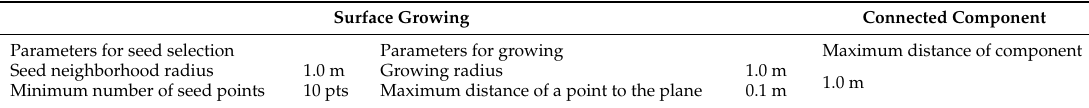
Table 1. Parameters for the surface growing and connected component algorithm.